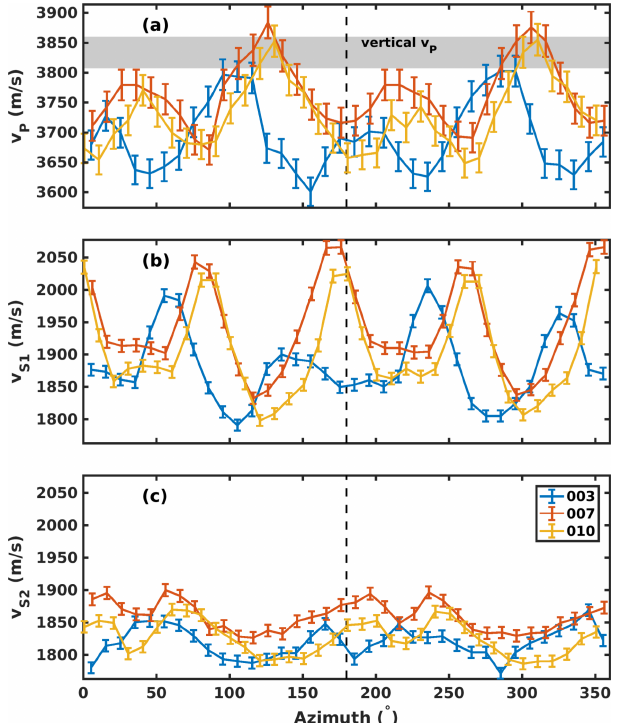
Figure 5. Ultrasonic multi-azimuth velocities for different core sec- tions relative to the macroscopic glacier flow direction (0 ◦ ). (a) P- wave velocity v P . The grey-shaded box shows the range of mea- sured vertical ultrasonic v P . (b) Fast S-wave velocity v S1 . (c) Slow S-wave velocity v S2 .